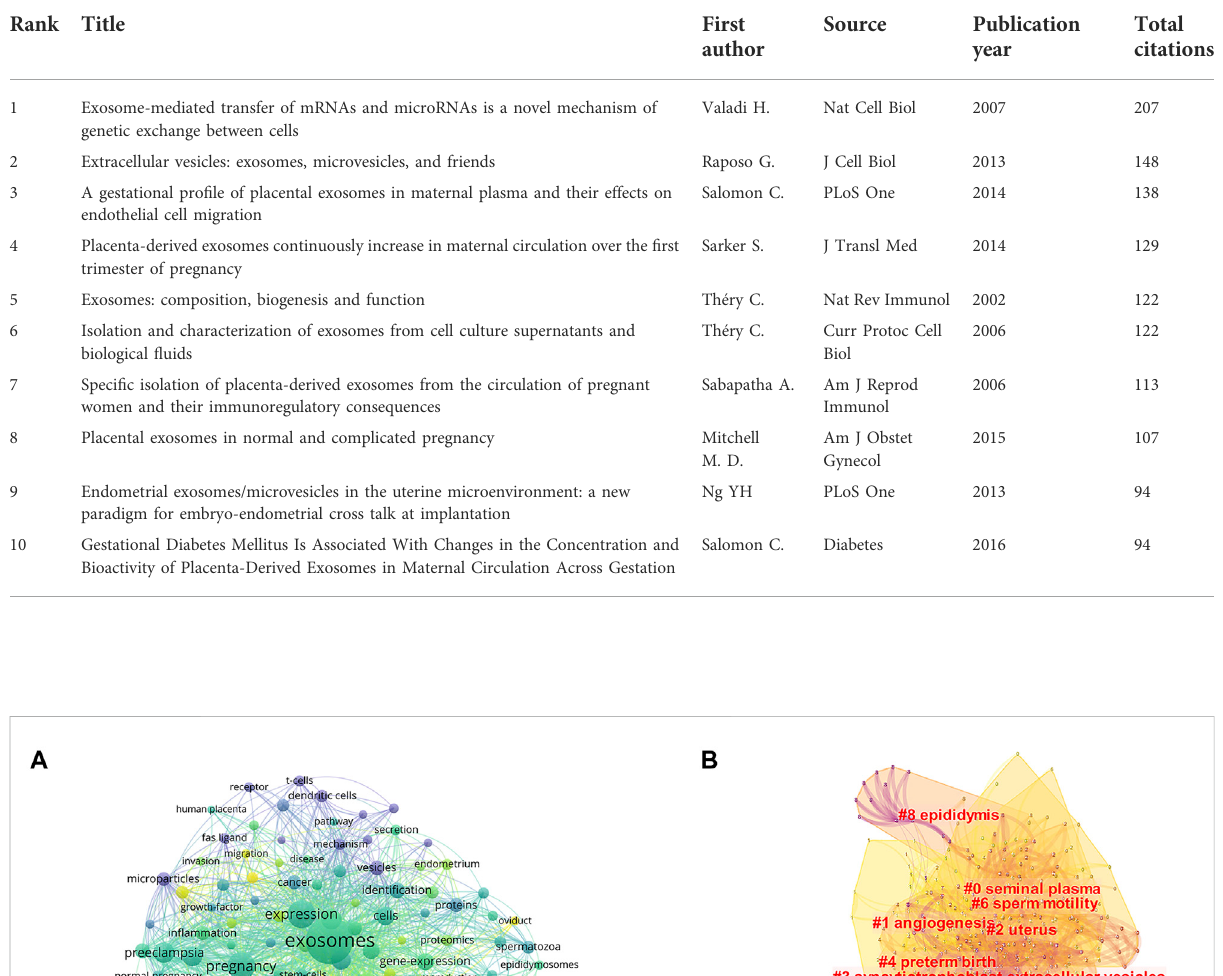
TABLE 5 Top 10 documents in co-citation analysis of publications on exosomes in